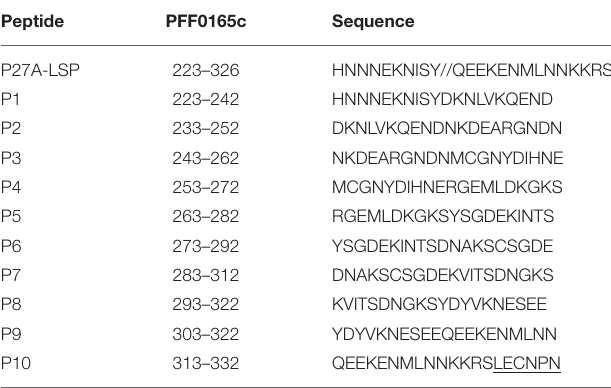
TABLE 1 | Sequences of P27A and overlapping 20-mers